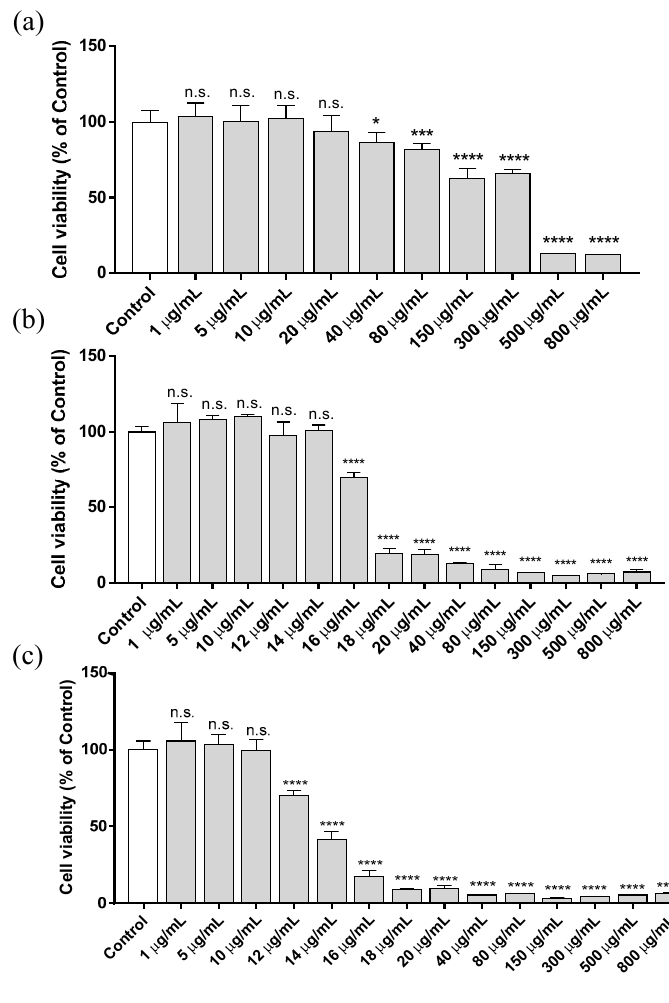
Figure 1. Cytotoxicity assay (MTT method) in human keratinocytes HaCaT cell line after exposing the cells for 3 h ( a ), 12 h ( b ) and 24 h ( c ) to several concentrations of ZnCl 2 , ranging from 1 to 800 µg/mL. Results represented are normalized to the control group (culture media without ZnCl 2 ). Data depicted as mean ± SD of six replicates. Significant differences with respect to control were determined by one-way ANOVA with Tukey’s correction for multiple comparisons: * p > 0.05; *** p > 0.001; **** p > 0.0001; n.s. = not significant. The EC 50 calculated for each exposure time is reported in Table 2. The highest cyto- toxic effect due to ZnCl 2 occurs within the first 12 h of exposure. The EC 50 at 12 h was more than 90% lower than that of the concentration obtained after 3 h of treatment. However, between 12 and 24 h of treatment, there was only a 20% reduction in EC 50 . In fact, it was only possible to detect this difference in EC 50 between 12 and 24 h with the addition of